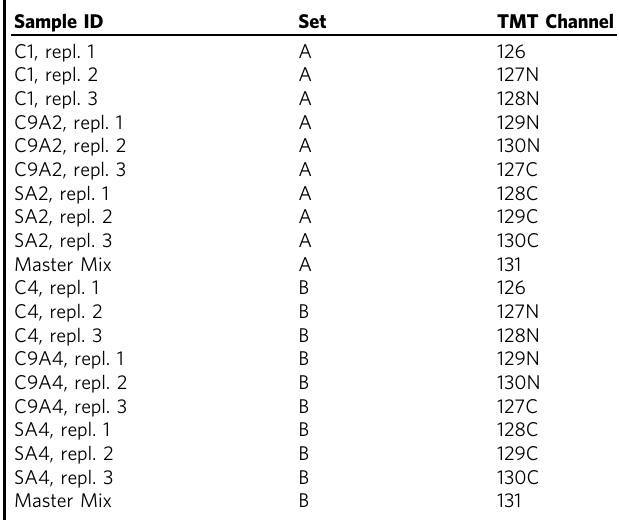
Table 1 Mass spectrometry and tandem mass tag